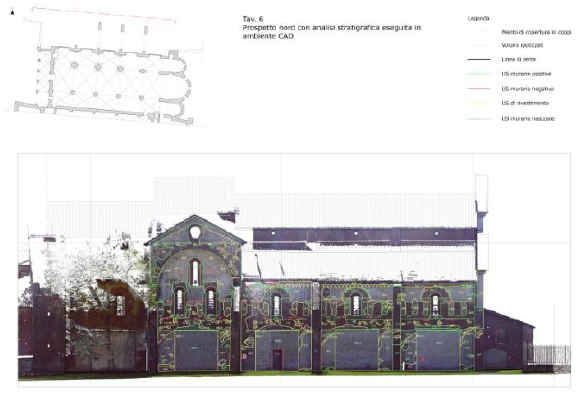
Figure8. RPAS - hexaKopter (Mikrokopter)